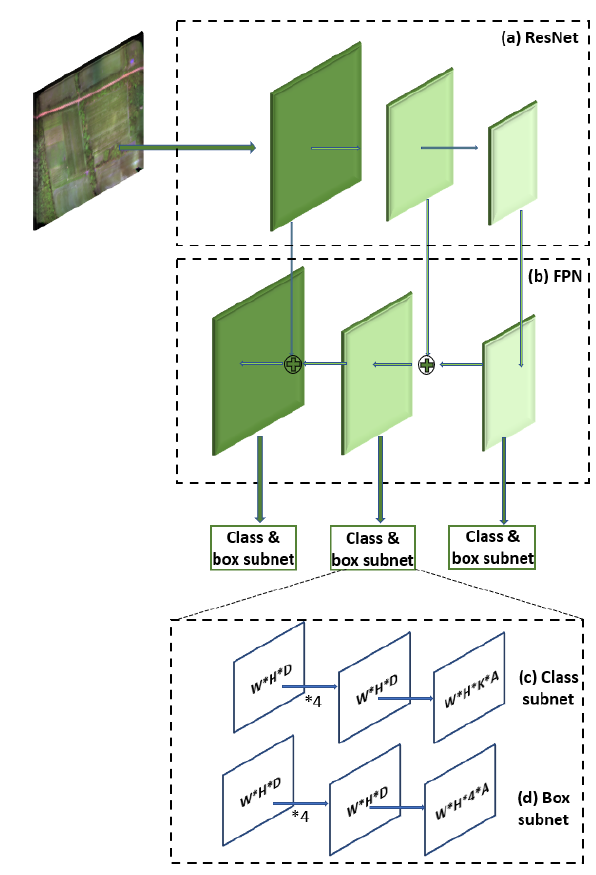
Figure 7. RetinaNet architecture: (a) ResNet backbone, (b) Feature Pyramid Network, (c) Classification subnet, and (d) Box regression subnet.